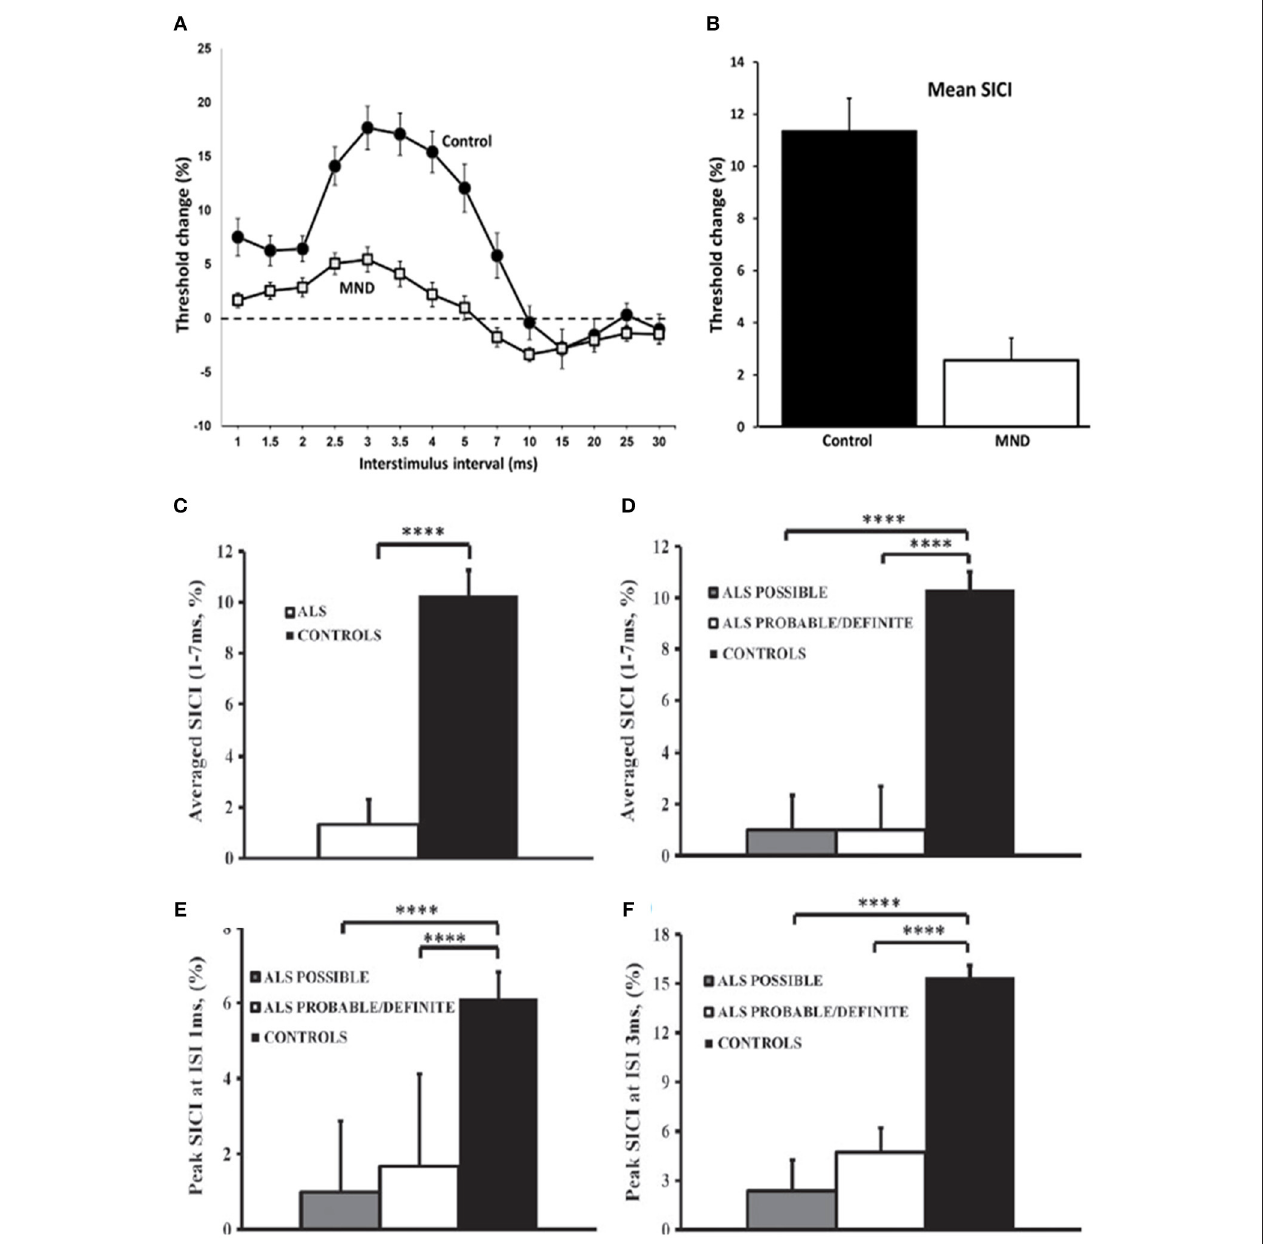
FIGURE 2 | Cortical excitability in motor neuron disease (MND). Paired-pulse subthreshold conditioning transcranial magnetic stimulation demonstrating (A) reduction in short-interval intracortical inhibition (SICI, above dotted line) and intracortical facilitation (ICF, below dotted line) and (B) significant reductions in averaged SICI (between interstimulus intervals of 1–7ms) in MND patients compared with controls (C) Averaged short-interval intracortical inhibition (SICI), between interstimulus interval (ISI) 1–7ms, was significantly reduced in amyotrophic lateral sclerosis (ALS). (D) The reduction of averaged SICI was comparable in Awaji subgroups. Peak SICI at ISI (E) 1ms, and (F) 3ms was significantly reduced in Awaji subgroups. **** P < 0.0001. Reproduced with permission license no. 4457360494951 (1) and license no. 4457440155614